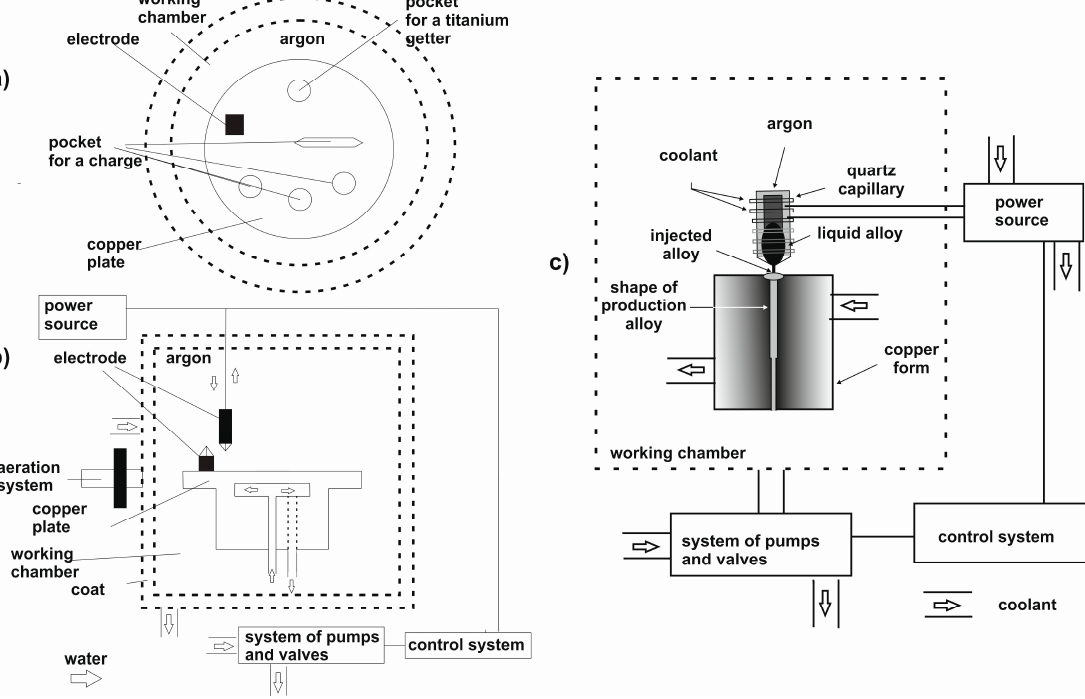
Figure1. Diagramofanarcfurnace: ( a )Topview, ( b )frontview, ( c )schemeforproducingrapidly-cooled Figure 1. Diagram of an arc furnace: ( a ) Top view, ( b ) front view, ( c ) scheme for producing alloys by an injection-casting rapidly-cooled alloys by an injection-casting method.